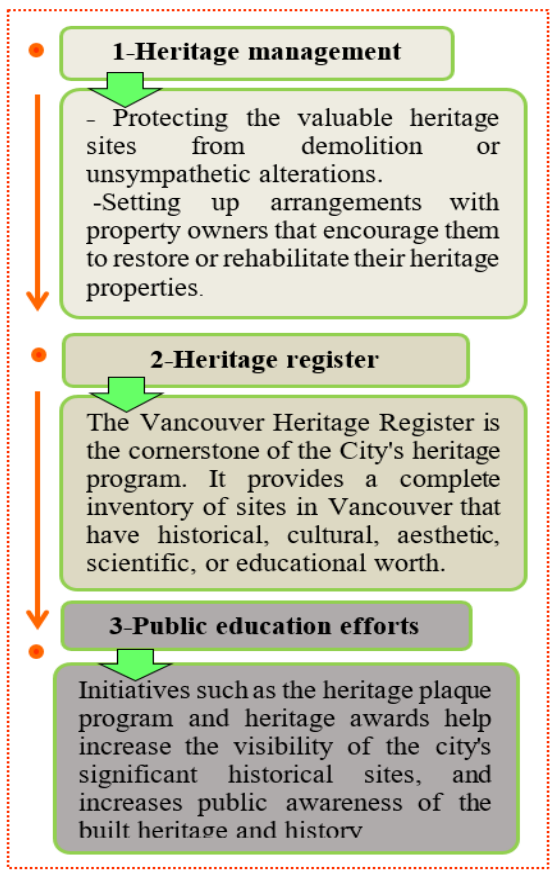
Figure 1. Three main Sequential stages of the proposed heritage